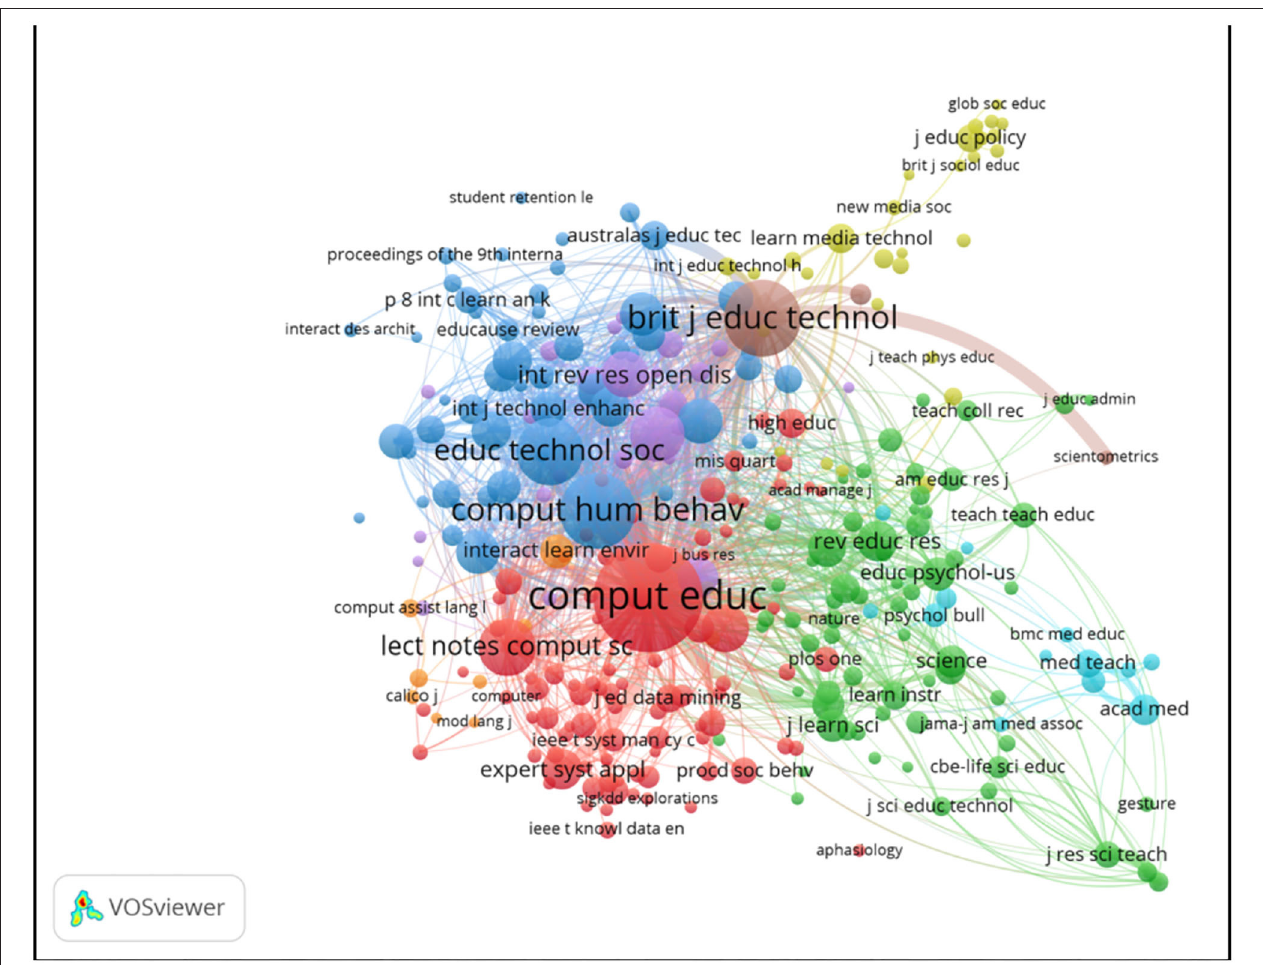
FIGURE 15 | Journal co-citation network visualization